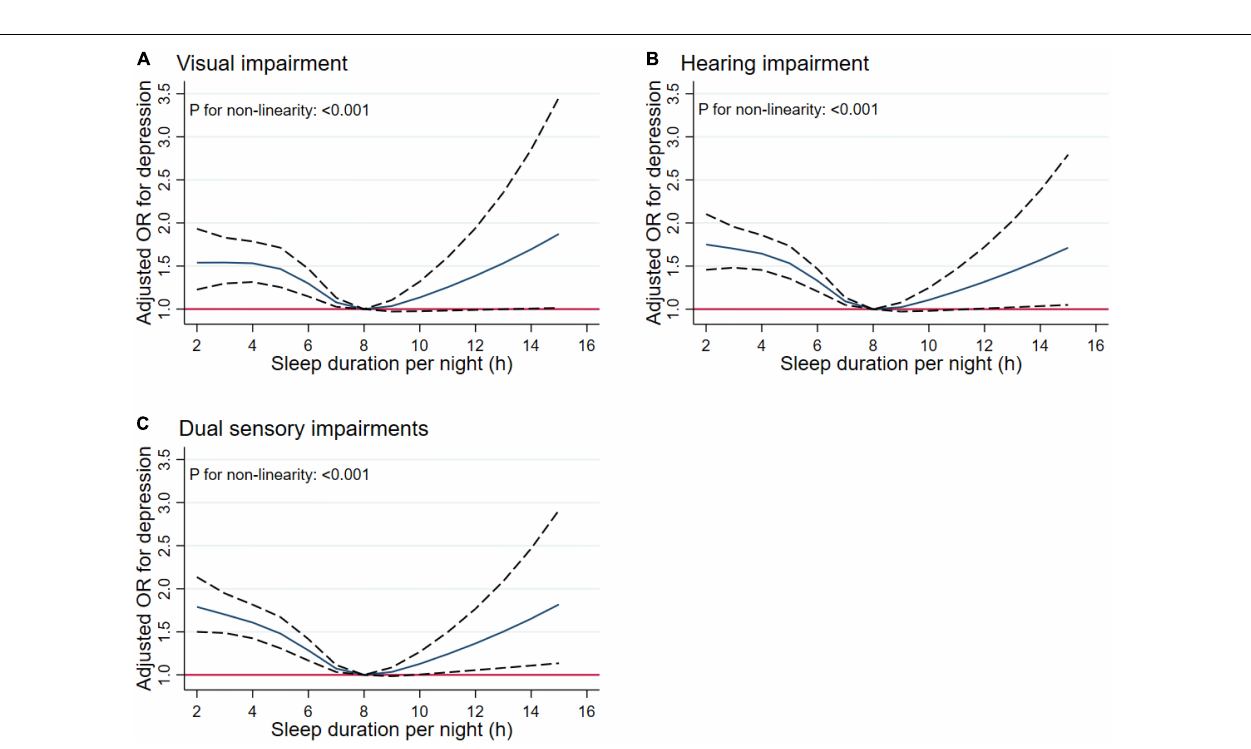
FIGURE 9 | Non-linear relationship of sleep duration and sensory impairments. Graphs display adjusted OR for depression (solid lines) of sleep duration with 95% CIs (dotted lines) for visual impairment (A) , hearing impairment (B) , and dual sensory impairments (C) .